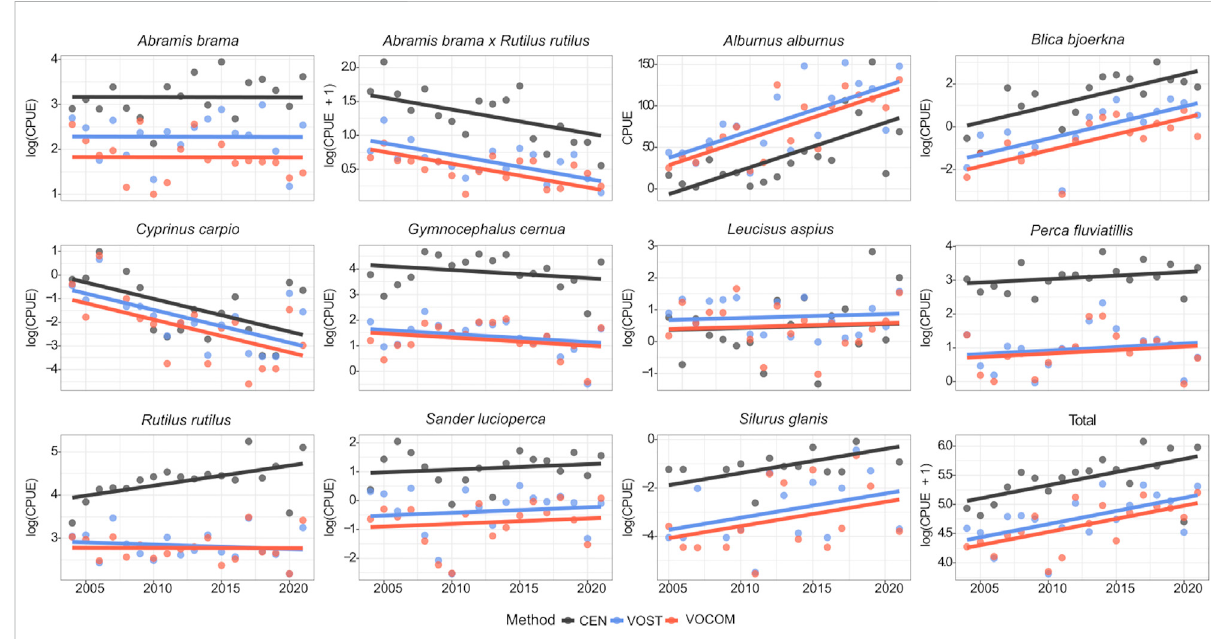
FIGURE 5 Temporal trends of CPUEs based on the ANCOVA model fi ts of transformed data determined by the three methods (CEN, VOST and VOCOM) for the dominant fi sh species and the whole fi sh community in the Ř ímov Reservoir (Czech Republic).